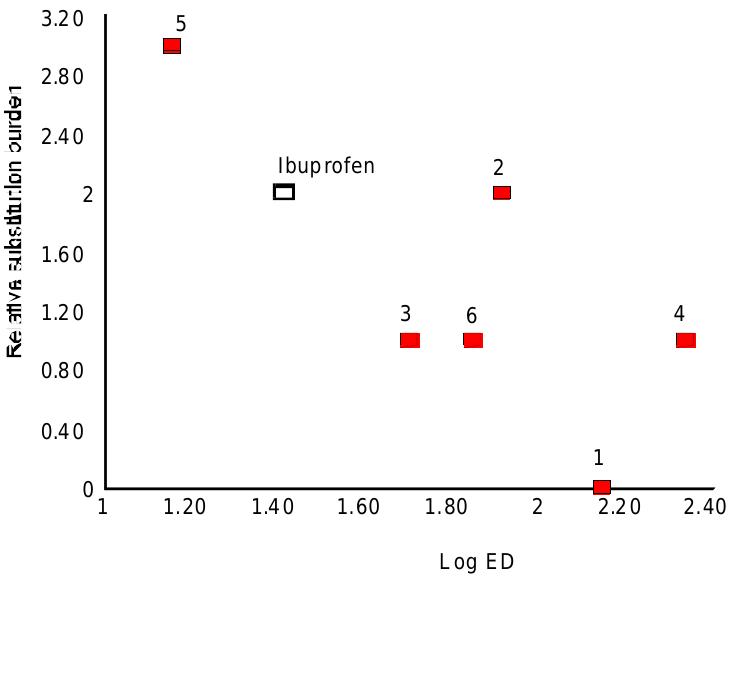
Figure 4 . Correlation of biological response and extent of α− and β -substitution of β - hydroxy propanoic